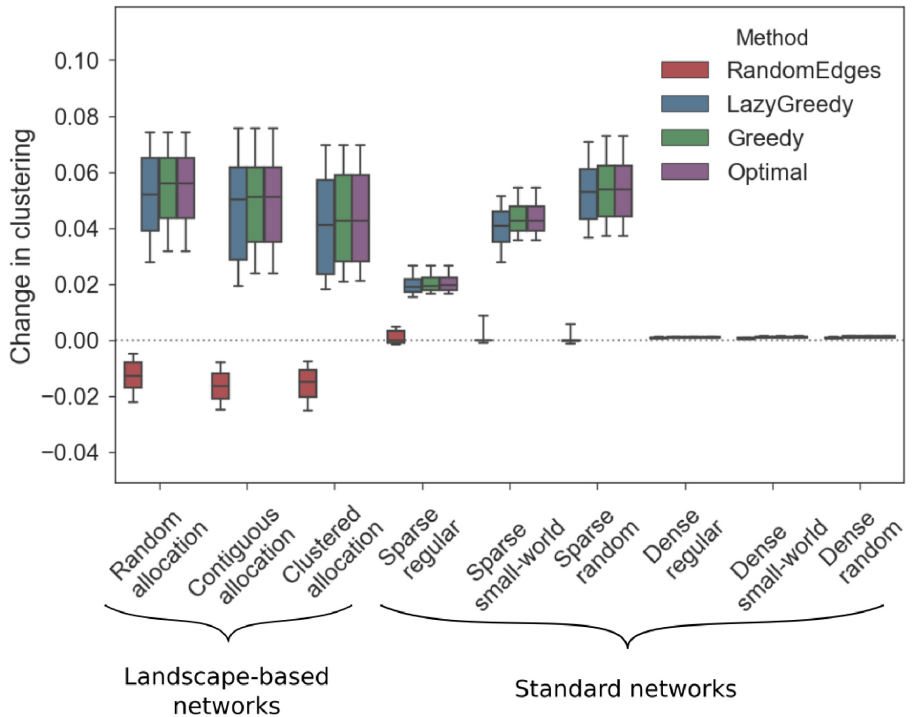
Fig 5. Greedy and Lazy Greedy algorithm applied to landscape-based and sparse networks lead to a higher increase in the clustering coefficient compared to randomly adding links. The horizontal axis shows the different network types, the vertical axis shows the change in clustering compared to the original network. The colour coding of the box-plots indicates the different algorithms.